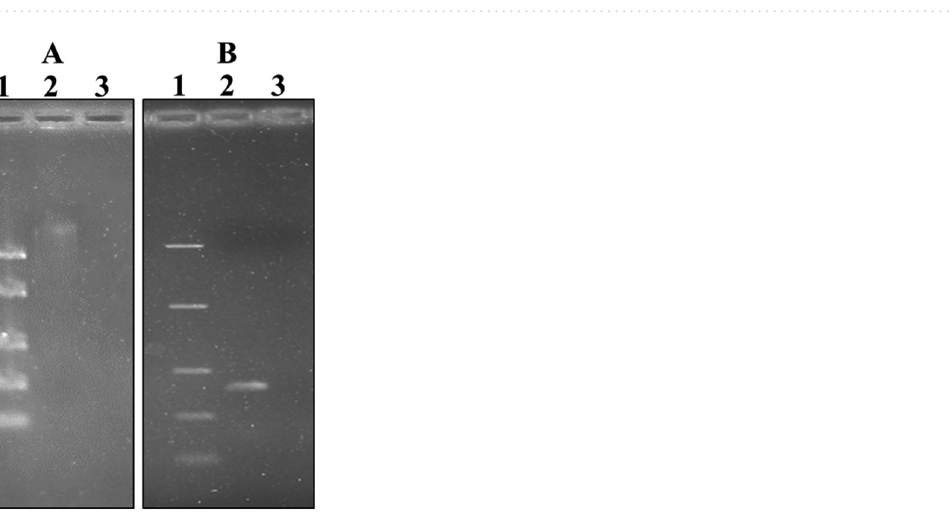
Figure 6. Proposed structures for compounds identified in ZF 52 ethyl acetate extract by UPLC-ESI–MS.